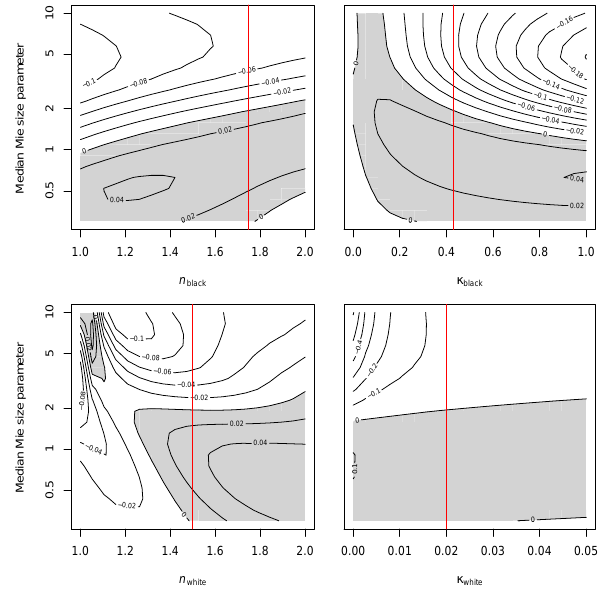
Figure 6. Relative difference of the absorption efficiency for well- mixed and core-shell particles as in Fig. 4 for the geometric stan- dard deviation σ g = 1 . 59, 2% black volume and varying refractive indices m black = n black + iκ black and m white = n white + iκ white . The solid red lines mark the refractive indices used in the previous fig- ures. For well-mixed particles, the volume average refractive index mixing rule is